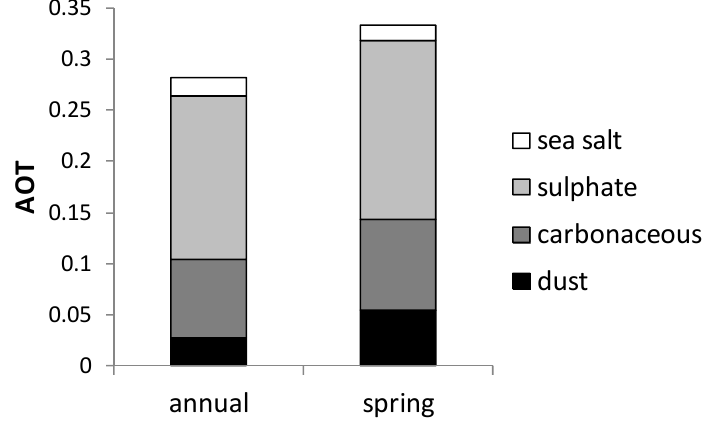
Figure 1. Contribution of aerosol type to simulated annual mean and spring (March, April and May) aerosol optical thickness (AOT) at a wavelength of 0.55 m around